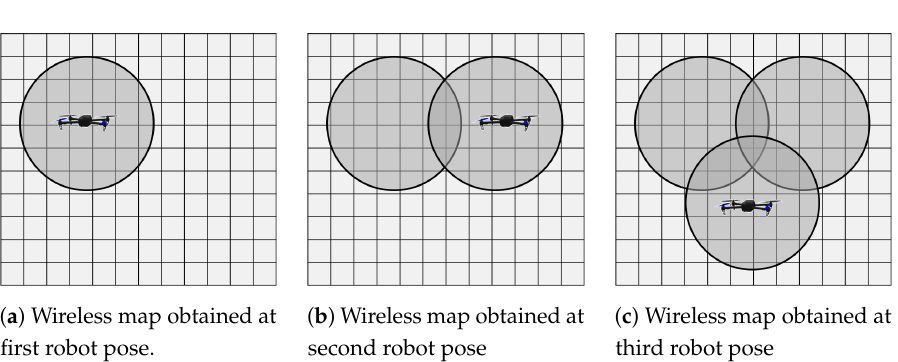
Figure 6. Trilateration